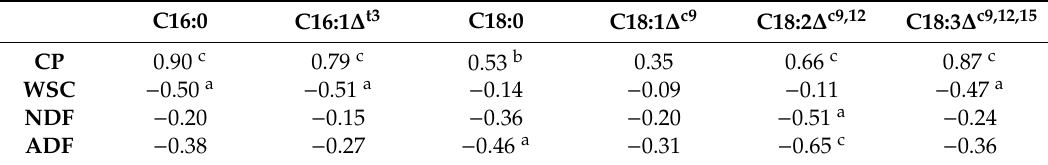
Table 3. Pearson’s correlation coe ffi cients for the relationships between fatty acid concentrations and feed value ( n =